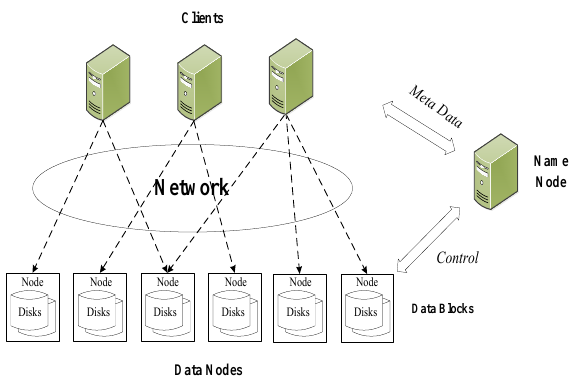
Fig. 2. The structure of data replication with